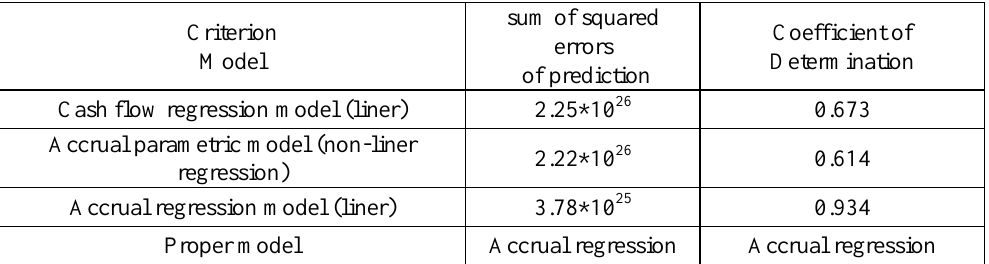
Table 10, Comparison of Linear and Nonlinear Regression Models to Predict Cash Flow Criterion Model